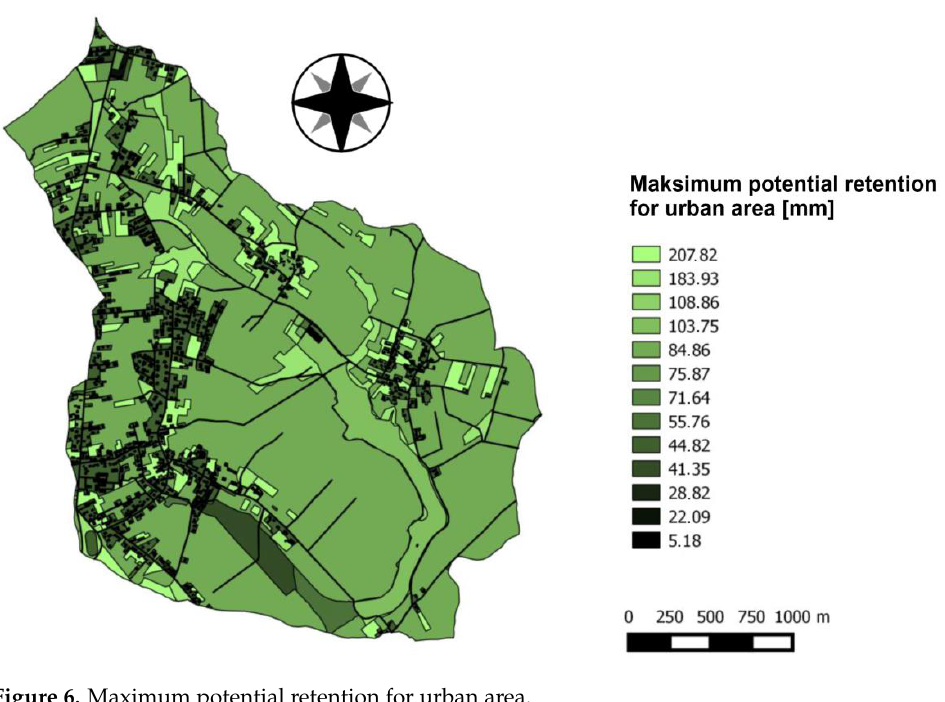
Figure 6. Maximum potential retention for urban area.